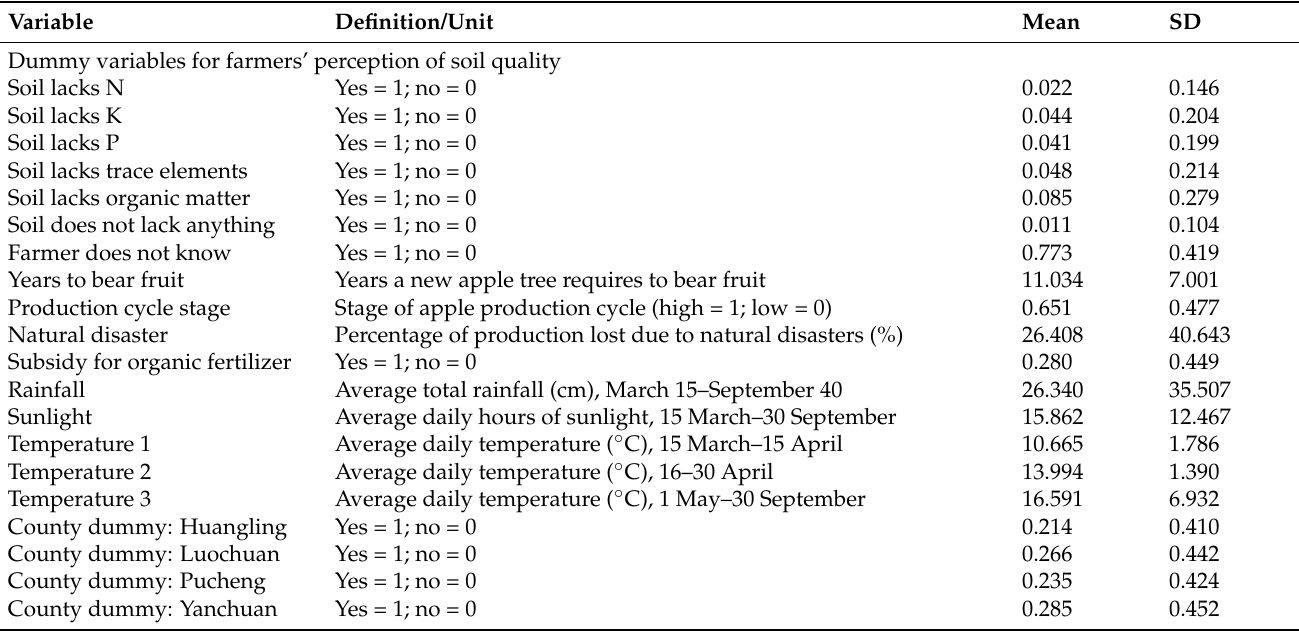
Table 3. Control variables: definitions and summary